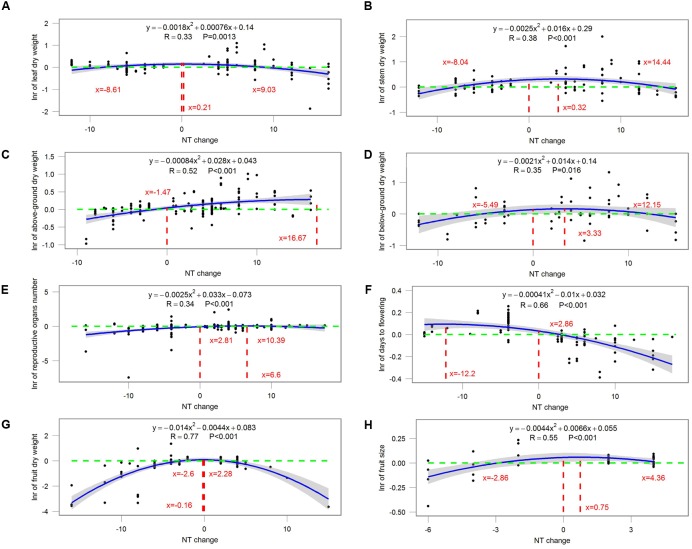
Correlations between the magnitude of NT treatment and the response ratio of (A) leaf dry weight; (B) stem dry weight; (C) above-ground dry weight; (D) below-ground dry weight; (E) number of reproductive organs; (F) days to flowering; (G) fruit dry weight and (H) fruit size. Each point represents response ratio (lnr) to HNT or LNT. Regression function, variation coefficient and p-value are presented in the middle of each graph. Different lines indicate X = 0 (red line), x-value when y is the maximum, crossing points of y = 0 (green line) and regression relationships.